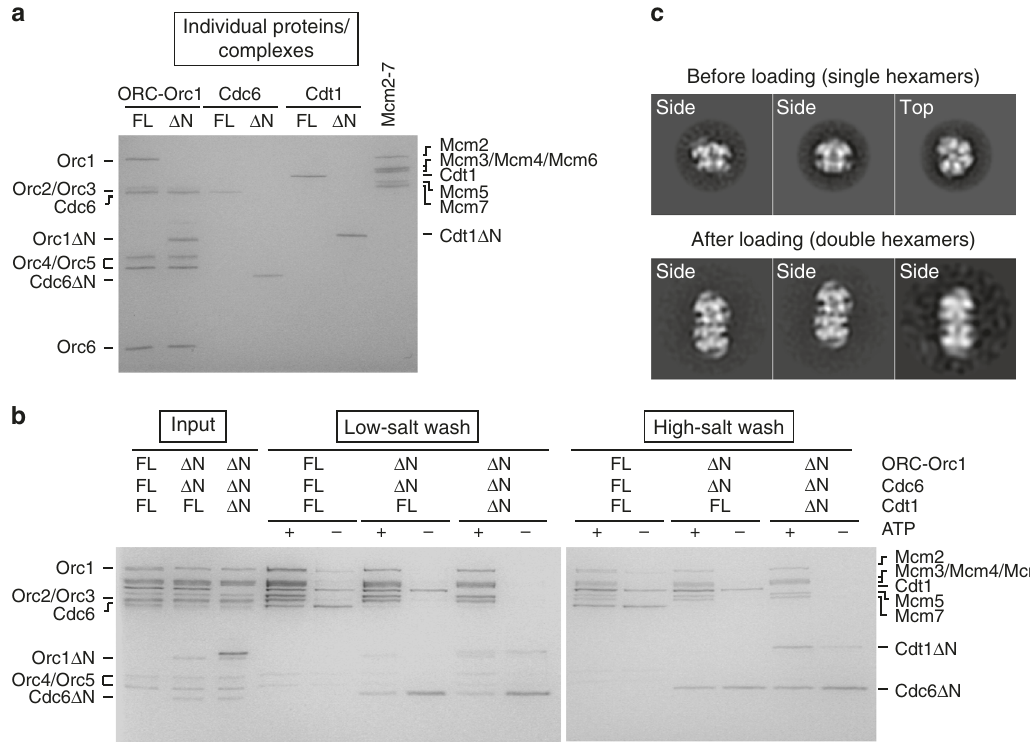
Fig. 1 Mcm2 – 7 loading does not require intrinsically disordered N-terminal regions (IDRs) of loading factors. a SDS-PAGE gel of puri fi ed Drosophila loading factors, either full-length proteins or constructs lacking IDRs ( Δ N). b Dm Mcm2 – 7 is recruited (low-salt wash) and loaded (high-salt wash) in an ATP-dependent manner by full-length and IDR-less Dm Orc1, Dm Cdc6, and Dm Cdt1 with similar ef fi ciency. Note that FL-Cdt1, Cdt1 Δ N, Cdc6, Cdc6 Δ N, and to some extent FL-Orc1 associate with beads nonspeci fi cally. c Loaded Dm Mcm2 – 7 are double-hexamers. Dm Mcm2 – 7 before and after loading was analyzed by negative-stain EM. 2D class averages show Mcm2 – 7 single-hexamers before loading but double-hexamers after loading. Source data are provided as a Source data fi